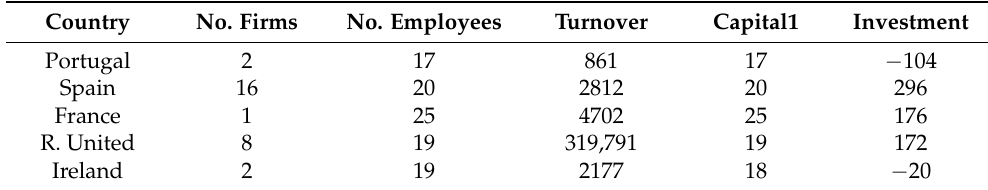
Table 2. Characteristics (averages) of companies by country, 2016–2020. Country No. Firms No.